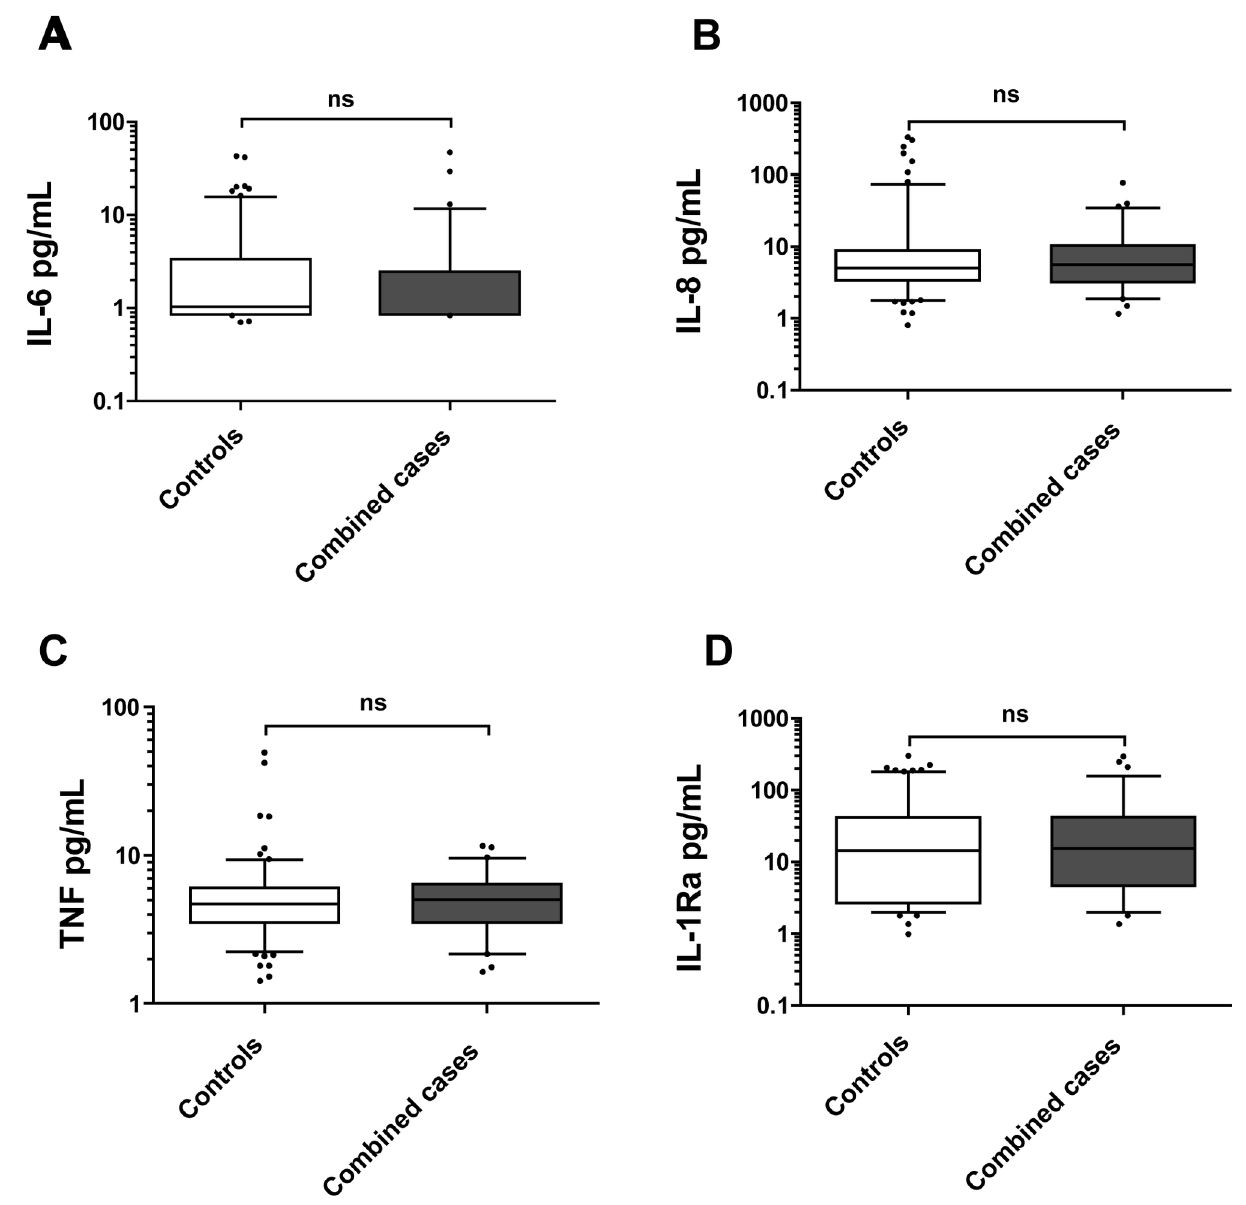
Figure 3. Basal cytokine levels in plasma from Combined cases and Controls. Spontaneous cytokine levels IL-6 ( A ), IL-8 ( B ), TNF ( C ) and IL-1Ra ( D ) were measured by Luminex, in plasma from healthy blood and plasma donors. Combined cases indicate individuals carrying combined polymorphisms of NLRP3 (Q705K) and CARD8 (C10X), whereas Controls are non-carriers of these polymorphisms (i.e. wild-types). ( A ) Spontaneous IL-6 levels (median values: 0.85 pg/mL (0.85-2.46) vs. 1.03 pg/mL (0.85-3.35), p =0.2416) comparing Combined cases (n=71) and Controls (n=143). ( B ) Spontaneous IL-8 (CXCL8) levels (median values: 5.61 pg/mL (3.2-10.25) vs. 5.05 pg/mL (3.38-8.81), p =0.9132) comparing Combined cases (n=71) and Controls (n=143). ( C ) Spontaneous TNF levels (median values: 5.04 pg/mL (3.51-6.42) vs. 4.69 pg/mL (3.52-6.05), p =0.4278) comparing Combined cases (n=70) and Controls (n=143). ( D ) Spontaneous IL-1Ra levels (median values: 15.30 pg/mL (4.65-42.12) vs. 14.29 pg/mL (2.68-41.49), p =0.8397) comparing Combined cases (n=71) and Controls (n=143). Box plots display the median value and 25 th and 75 th percentile. Whiskers represent 5-95 percentiles and dots the outliners. Data were analyzed by Mann-Whitney U-test as distribution was non-normal. ns = non-significant for Combined cases vs. Controls values.